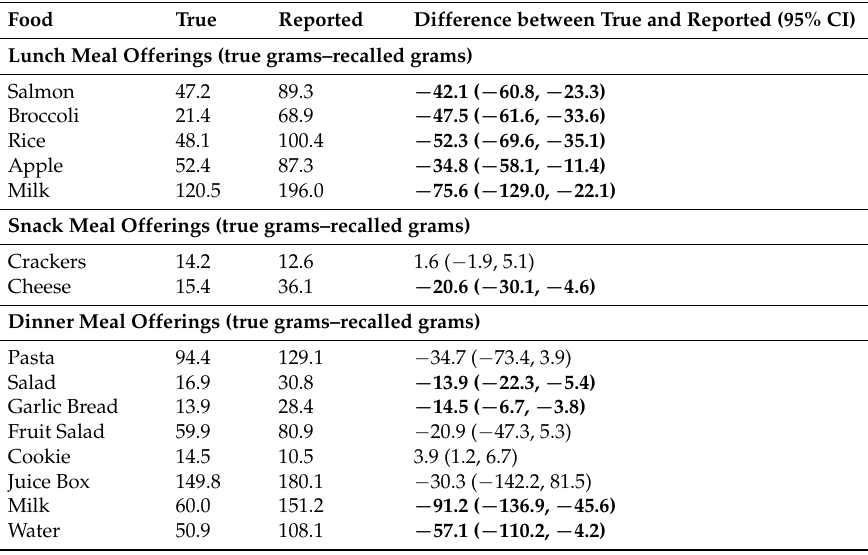
Table 6. Average amounts (g) of true and reported intake by food